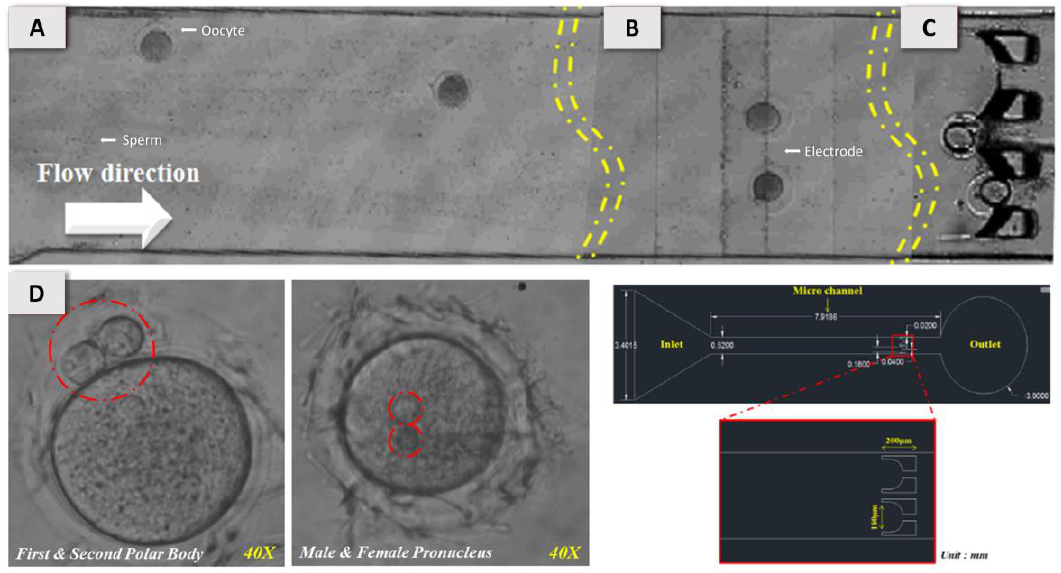
Figure 4. Illustration of the experimental process in the DEP microfluidic chip. ( A ) The mouse oocytes and sperm were loaded into a microchannel with volume flow rate 0.5 –1.0 μL ·min − 1 . ( B ) At the applied AC voltage 10 V pp at 1 MHz, the oocytes and sperm were trapped with the positive dielectrophoretic force between the two electrode pads. The local sperm concentration increased to 100 × 10 6 sperm·mL − 1 , regardless of the original sperm concentration. The white arrow shows the direction of the flow. ( C ) On release of the p-DEP force after trapping for 1 min, the oocytes and sperm were trapped with the microstructure behind the microchannel for natural insemination for 1 h. ( D ) A second polar body and two pronuclei were observed after 4 – 10 h.